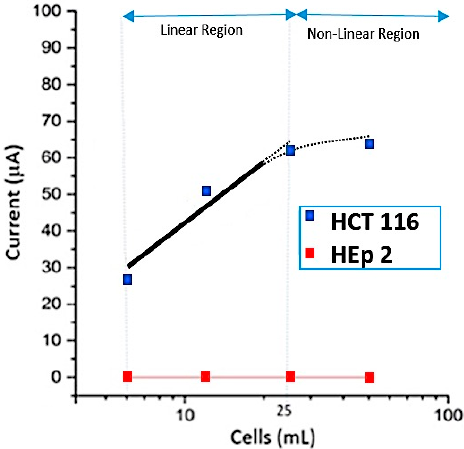
Figure 6. Calibration curve for cancer and control cells. Each experiment related to CV curves was repeated more than three times.